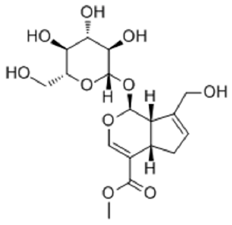
Figure 24. Structure of geniposide isolated from Gardenia jasminoides Ellis fruits.